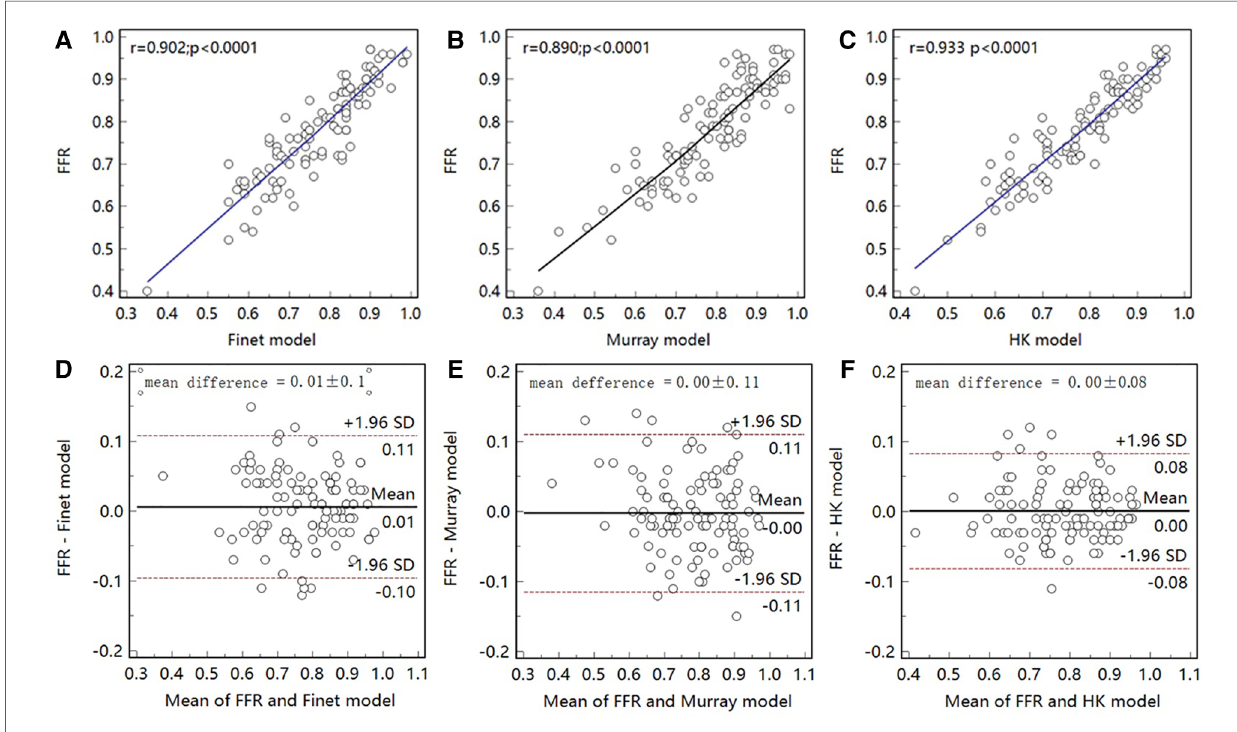
with invasive FFR. Table 4 shows the diagnostic performance of the three models (with invasive FFR (cid:6) 0 : 80 as the disease benchmark). From the ROC curve ( Figure 11 ), it can be seen that the HK